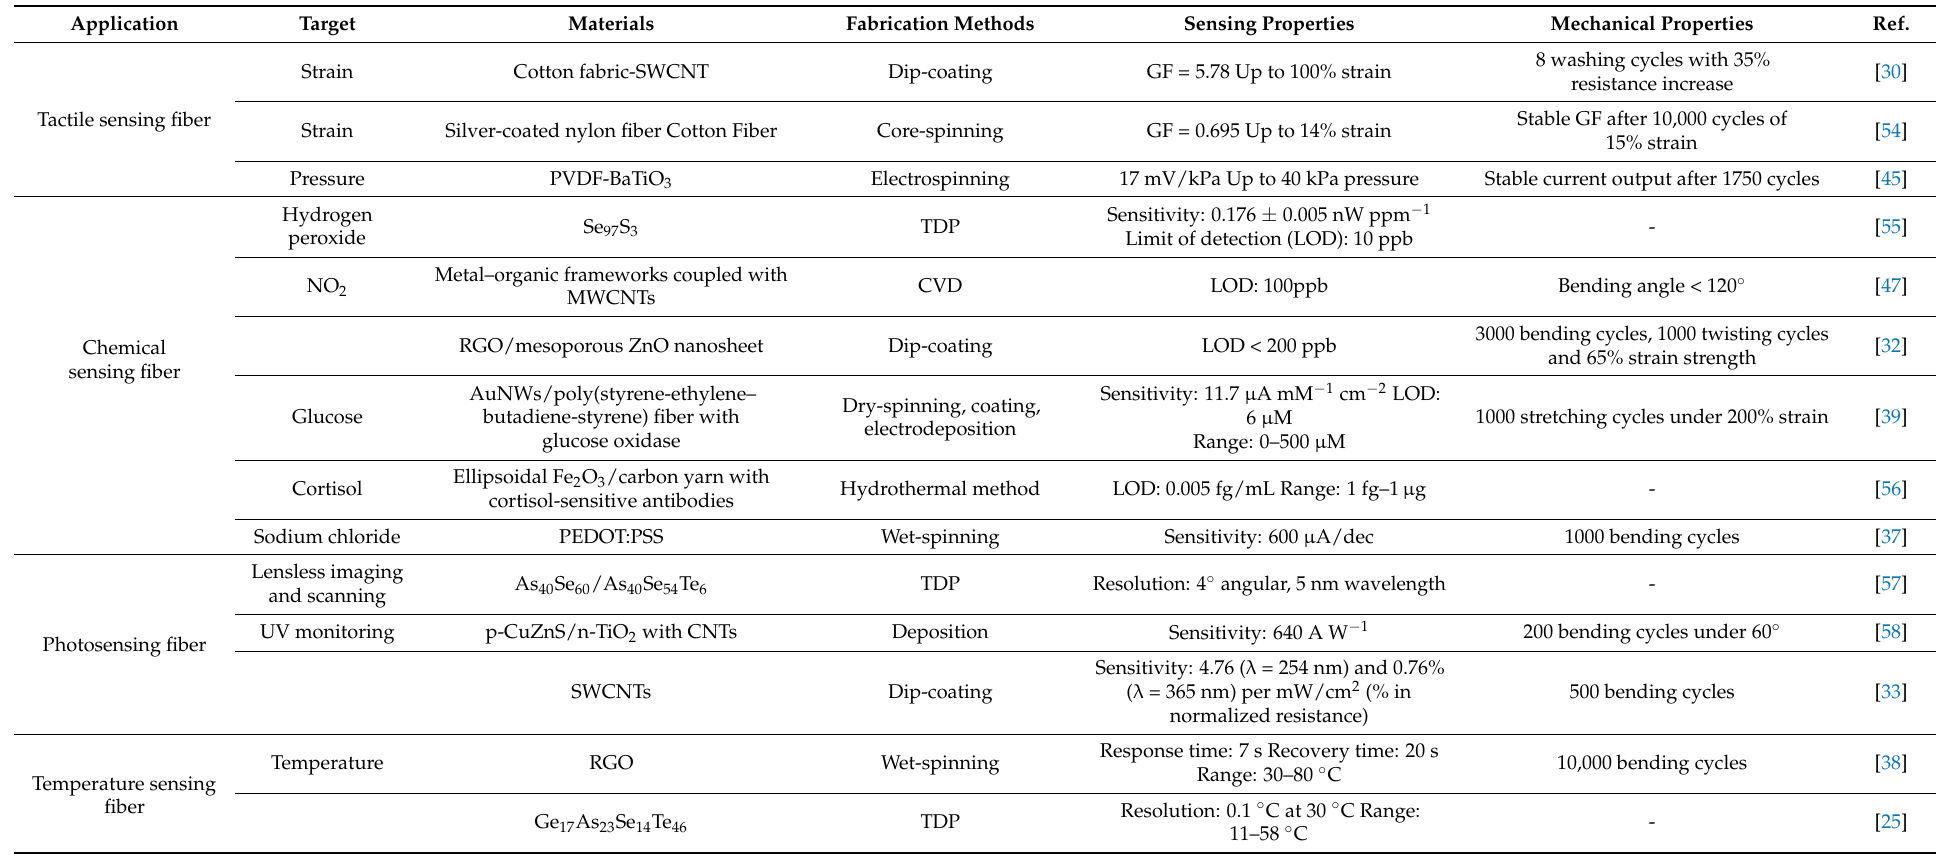
Table 2. Summary of fiber-based